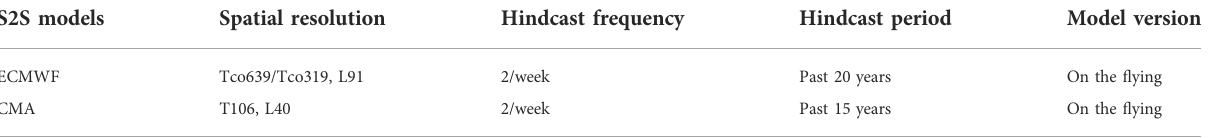
TABLE 1 Information on the S2S models of ECMWF and CMA. S2S